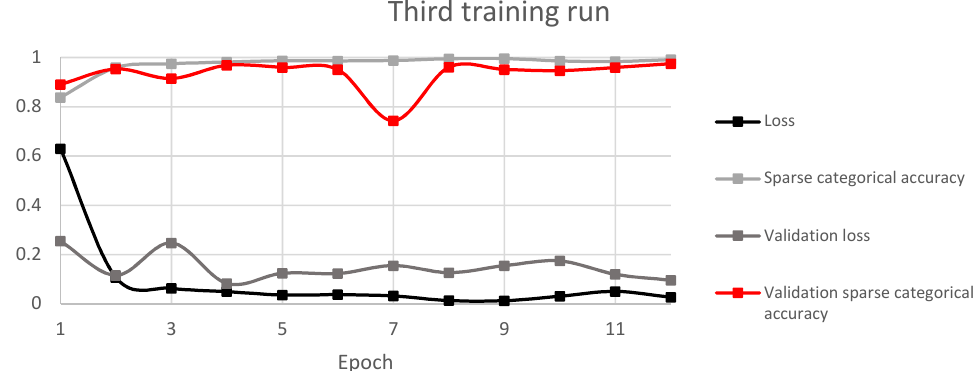
Figure 12. Third training run process.